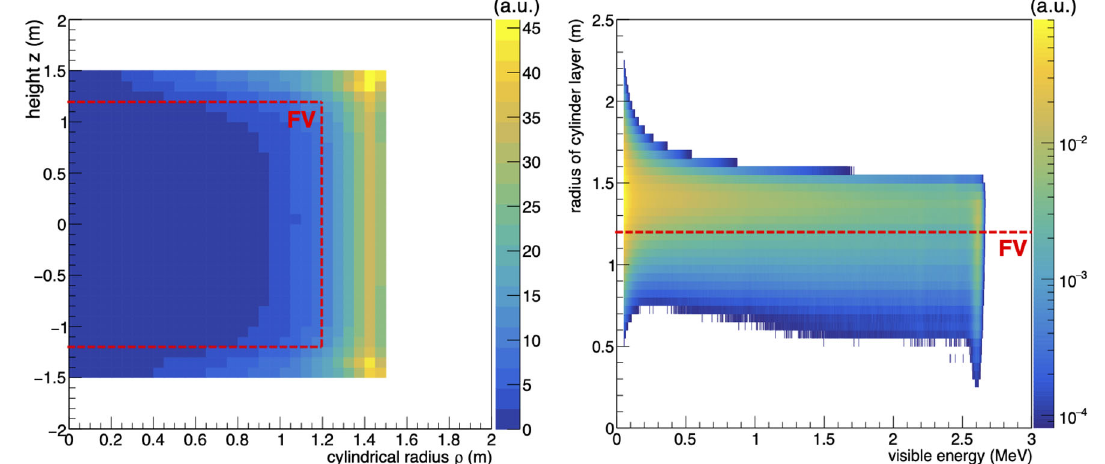
Fig. 4 Event distributions of the external gamma-ray background, assuming a photoelectron yield of 1500 pe/MeV and Gaussian energy andvertexsmearing.Left:spatialdistributionoftrueenergydepositions inside the Acrylic Vessel. Right: cylinder-layer distribution of recon-